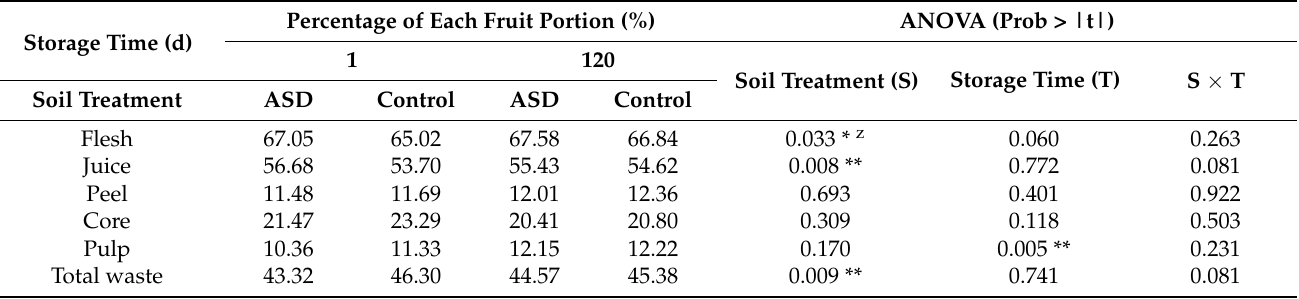
Table 1. Effect of soil treatment and storage time on juice production and waste of winter melons. Storage Time (d)